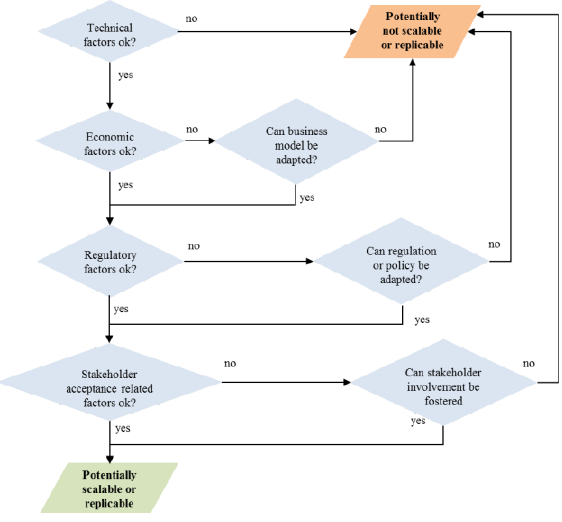
Figure 1. Overview of the methodology for assessing the factors.